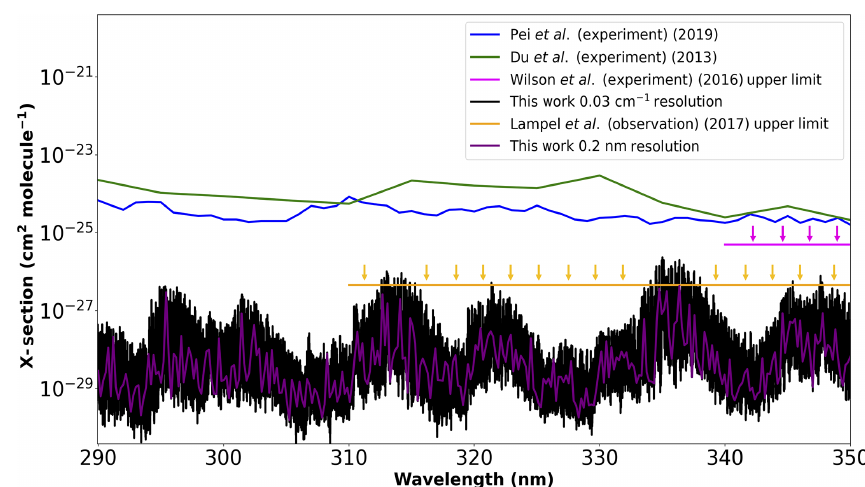
Figure 4. Cross sections calculated using our new PES with the CKAPTEN DMS (Conway et al., 2018) at two different resolutions, compared to the measurements by Du et al. (2013), Pei et al. (2020), and the upper limits by Wilson et al. (2016) and Lampel et al.